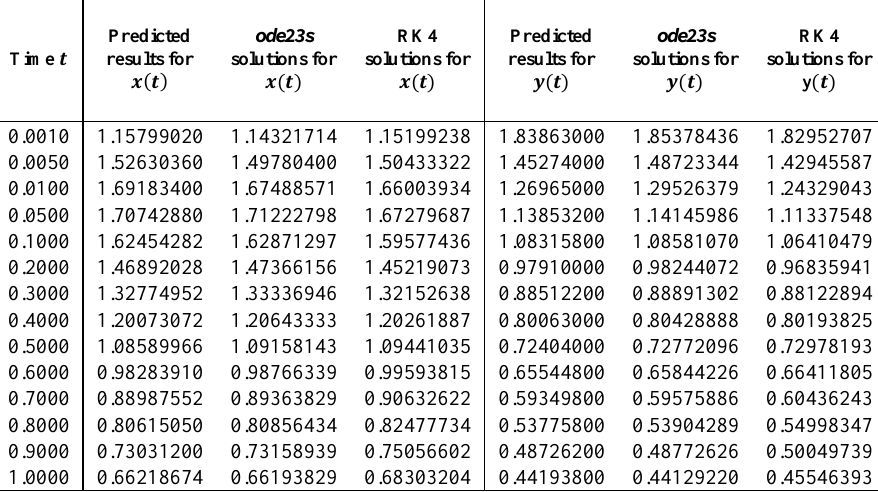
Table 3. Comparison of the predicted results with the ode23s and RK4